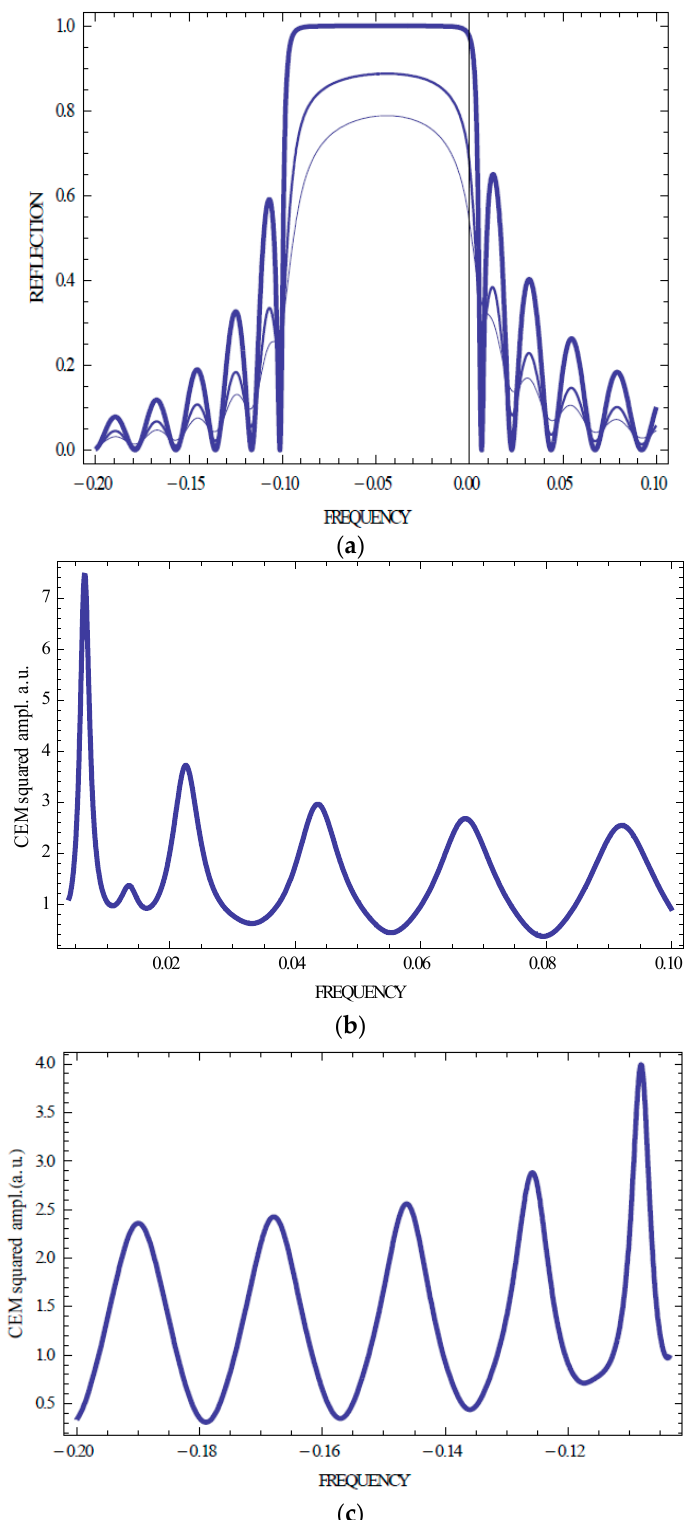
Figure 3. (a–c) The same as Figure 2 for the CLC layer thickness in period number N = 150. Figure 3. ( a – c ) The same as Figure 2 for the CLC layer thickness in period number N =